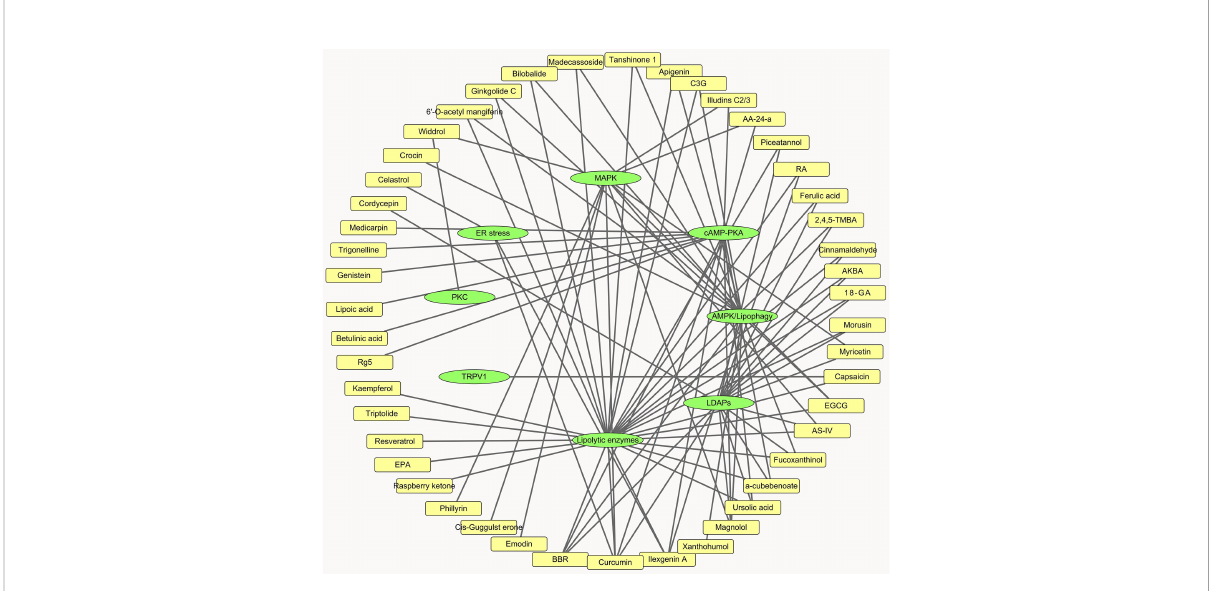
FIGURE 3 Network analysis of natural products and lipolytic